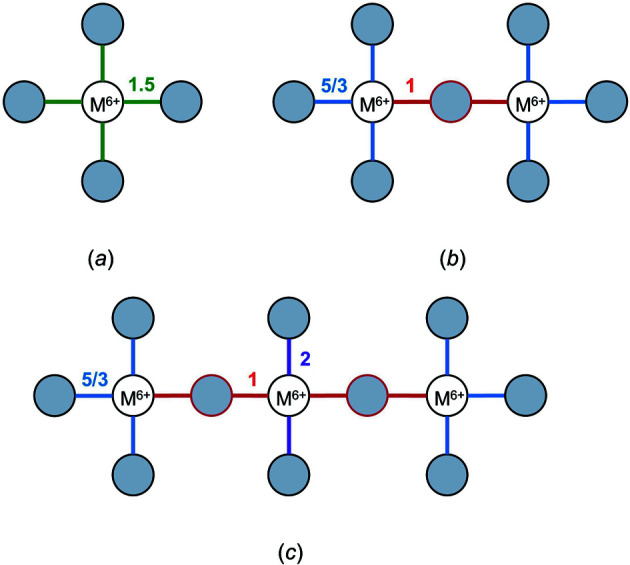
Bond-valence patterns arising from various corner-sharing tetrahedra for the +6 oxidation state for (a) monomers, (b) dimers and (c) linear oligomers and chains. Shaded spheres represent O2−.